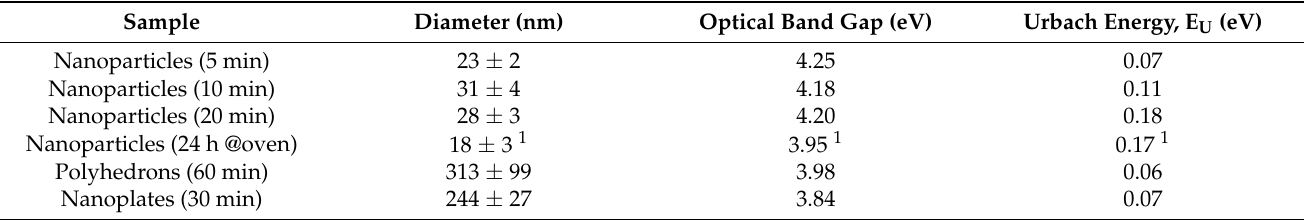
Table 2. Size, optical band gap, and Urbach energy of Zn 2 SnO 4 nanoparticles (different synthesis duration), polyhedrons, and nanoplates. The diameter values were determined through the ImageJ software. The presented values correspond to the average of 10